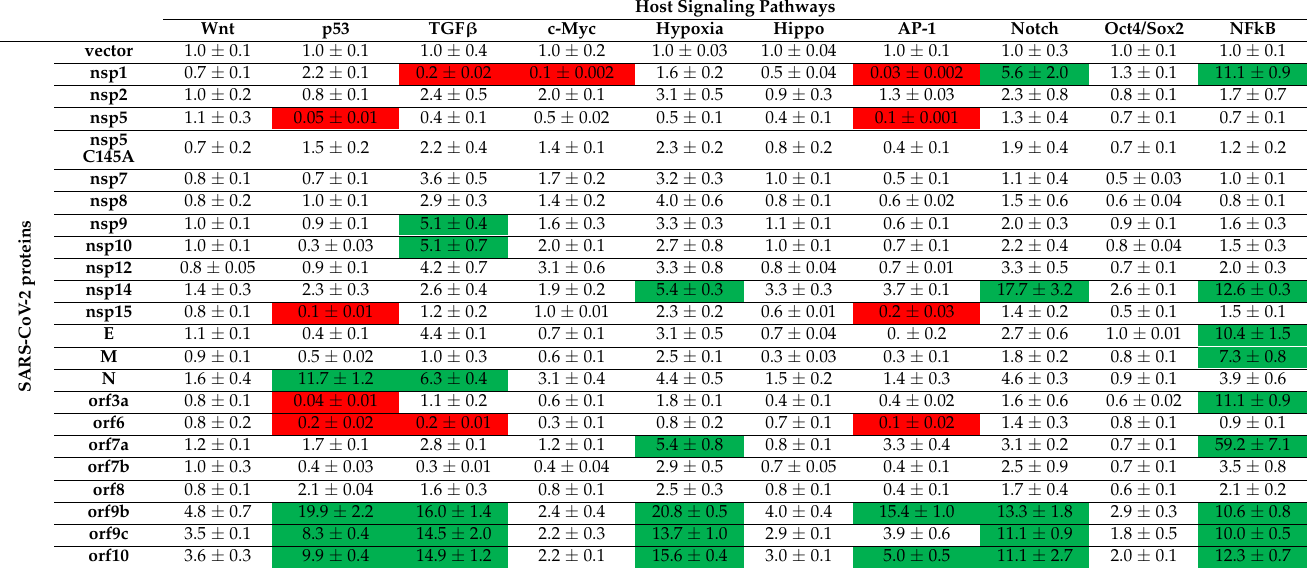
Table 1. Summary of the results of the signaling pathway luciferase reporter screen. Data show the av- erage of three independent luciferase assays ( n = 3). Fold change relative to the vector-transfected sam- ple and standard deviations are shown. Green ≥ 5-fold upregulation, red ≥ 5-fold downregulation. Host Signaling Pathways Wnt p53 TGF β c-Myc Hypoxia Hippo AP-1 Notch Oct4/Sox2 NFkB